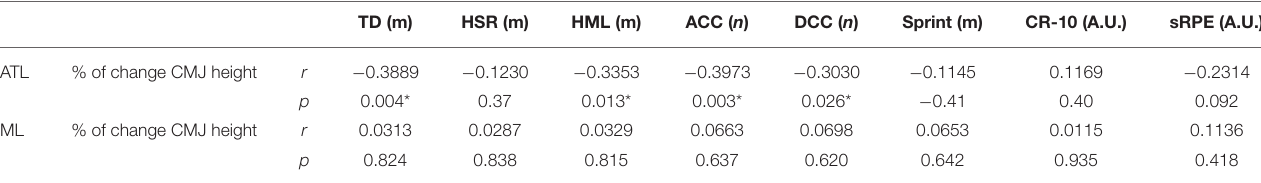
TABLE 4 | Correlation between percentage of change of CMJ and accumulated training load and ML demands.